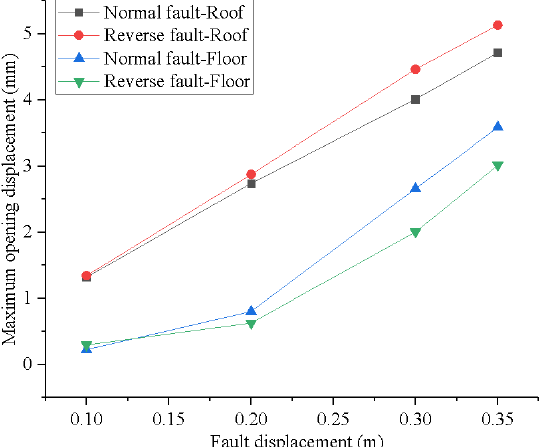
Figure 9. Relationship between the maximum opening displacement and fault displacement.